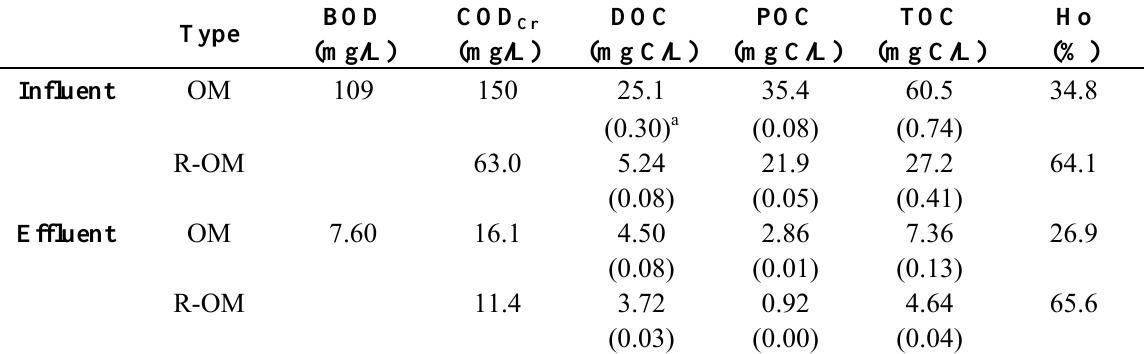
Table 1. Organic matter (OM) concentrations and the distribution of hydrophobic fractions for influent and effluent sewage from a wastewater treatment